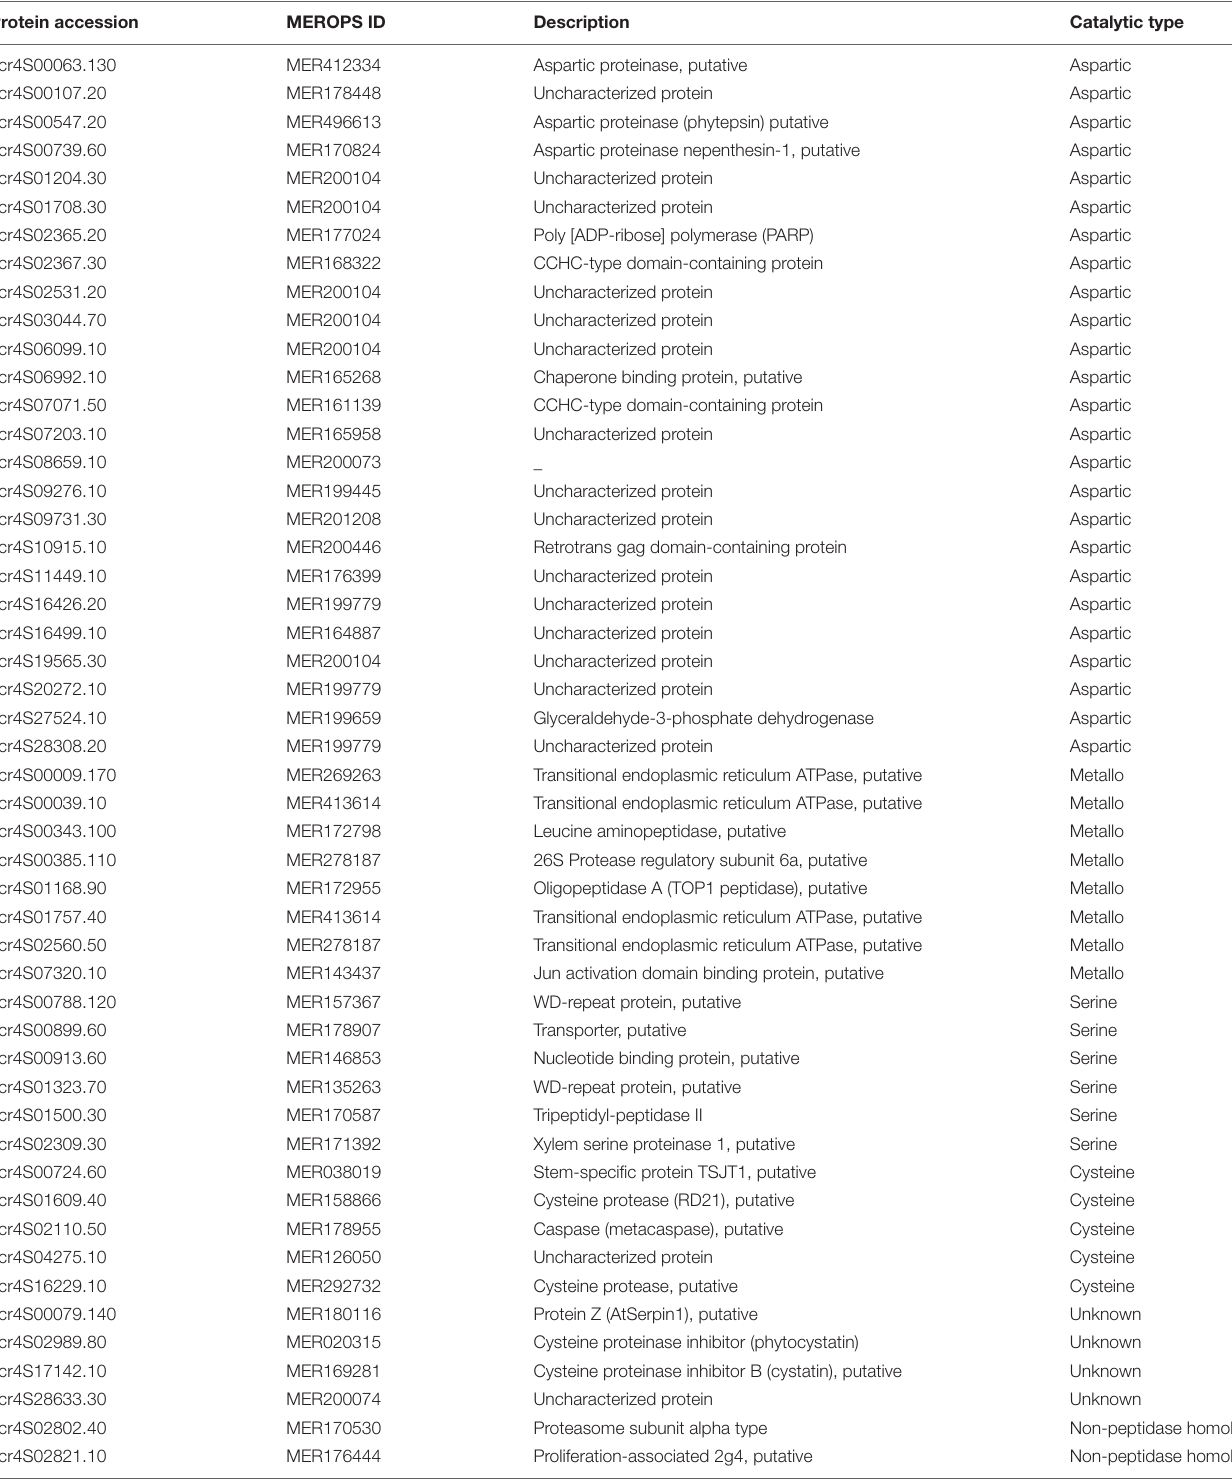
TABLE 5 | A list of peptidases and their inhibitors identified from the embryo of mature J. curcas